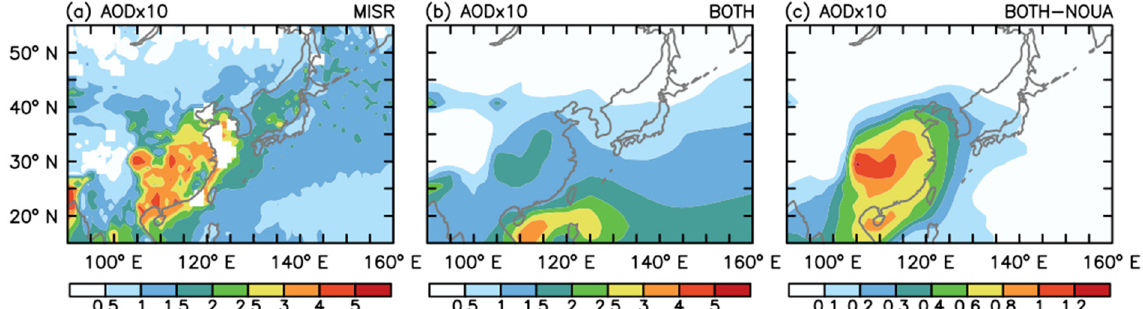
Figure 1. Climatological November–December–January (NDJ) mean aerosol optical depth (AOD; multiplied by 10, unitless) in East Asia averaged over the period ( a ) 2000–2020 from Multiangle Imaging Spectroradiometer (MISR) data and ( b ) the last 20 years from the BOTH experiment. ( c ) Same as ( b ) but for the BOTH-minus-NOUA difference. Note the smaller interval in ( c ).